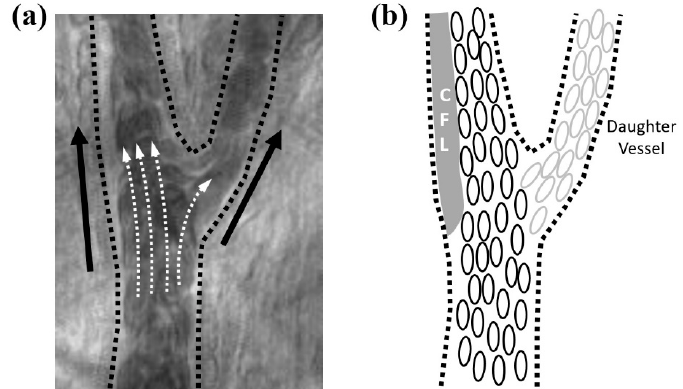
Figure 2. In vivo observation of CFL enhancement due to a local hematocrit reduction at an arteriolar bifurcation ( a ) and its corresponding illustration for RBCs trajectory ( b ); Dashed and solid arrows indicate the cell trajectory and flow direction, respectively. Bold cells represent RBCs of higher concentration in the main channel while gray cells indicate a lower concentration of RBCs in the daughter vessel.